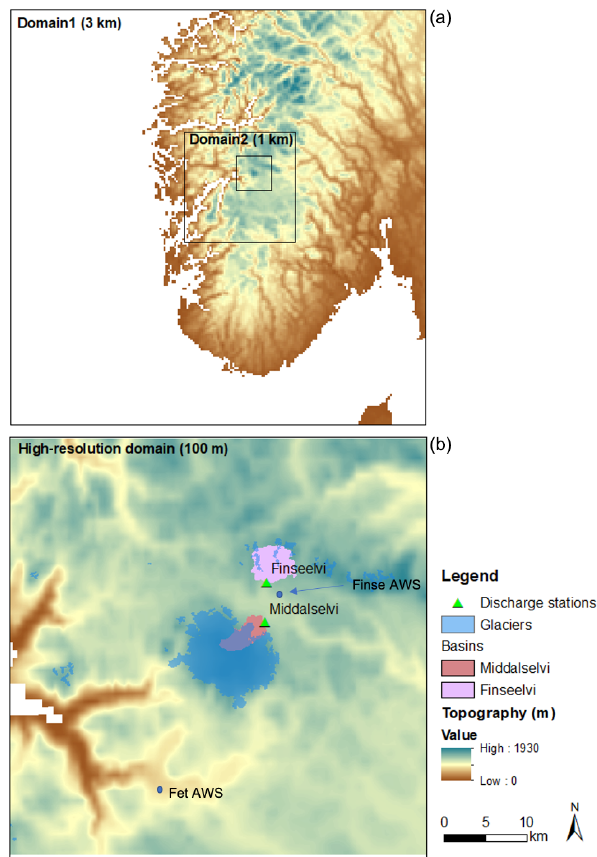
Figure 2. Model domains. Panel (a) shows the WRF domains with 3 and 1km grid spacing. Panel (b) shows the high-resolution do- main (100m grid spacing) used with WRF-Hydro/Glacier. Further- more, the outline of Hardangerjøkulen and the river basins of the two rivers with discharge observations are included as